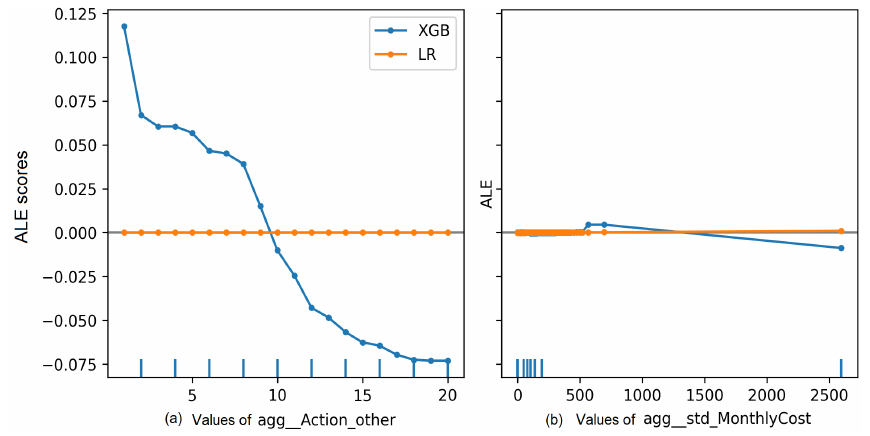
Figure 11. ALE scores of BPIC2017_Accepted event log.